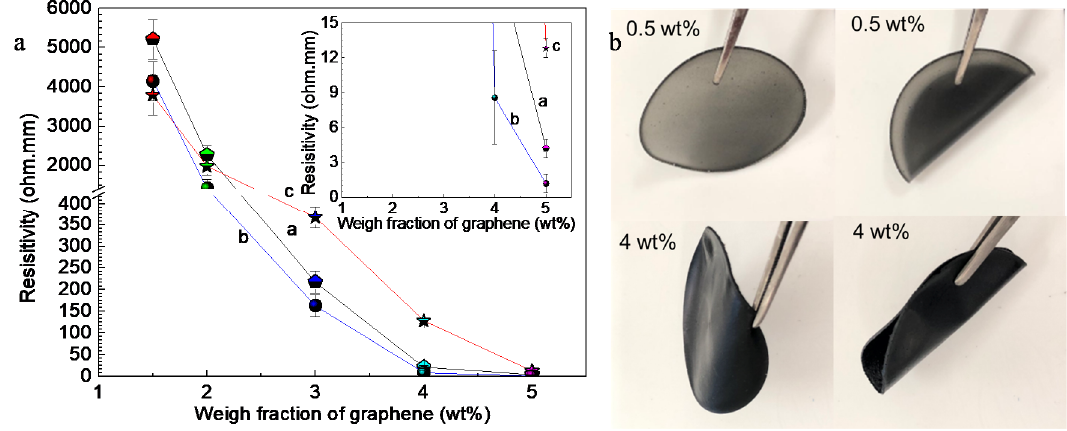
Figure 1. ( a ) Resistivity of G-TPU composite films with different mass contents of graphene and TPU initial concentrations of 10 wt% (curve a), 20 wt% (curve b), and 30 wt% (curve c), respectively, and ( b ) photos of samples with the mass content of graphene of 0.5 wt%, and 4.0 wt%, respectively, and initial TPU concentration of 20%.